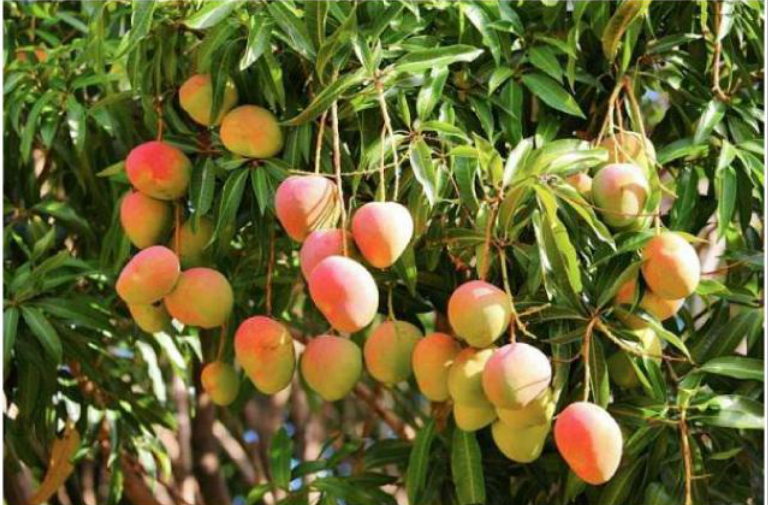
Figure 12. Mangifera indica L.